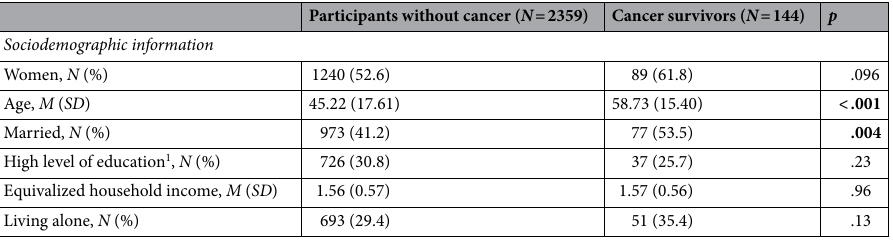
Table 1. Sample characteristics (stratified by self-reported cancer diagnosis). Univariate comparisons are Chi- square or t-tests, where appropriate. Categorical data is shown as N and %, continuous variables as means and standard deviations. Significant values are in bold. 1 German Abitur (12–13 years of school) or equivalent that allows for postsecondary education at universities.